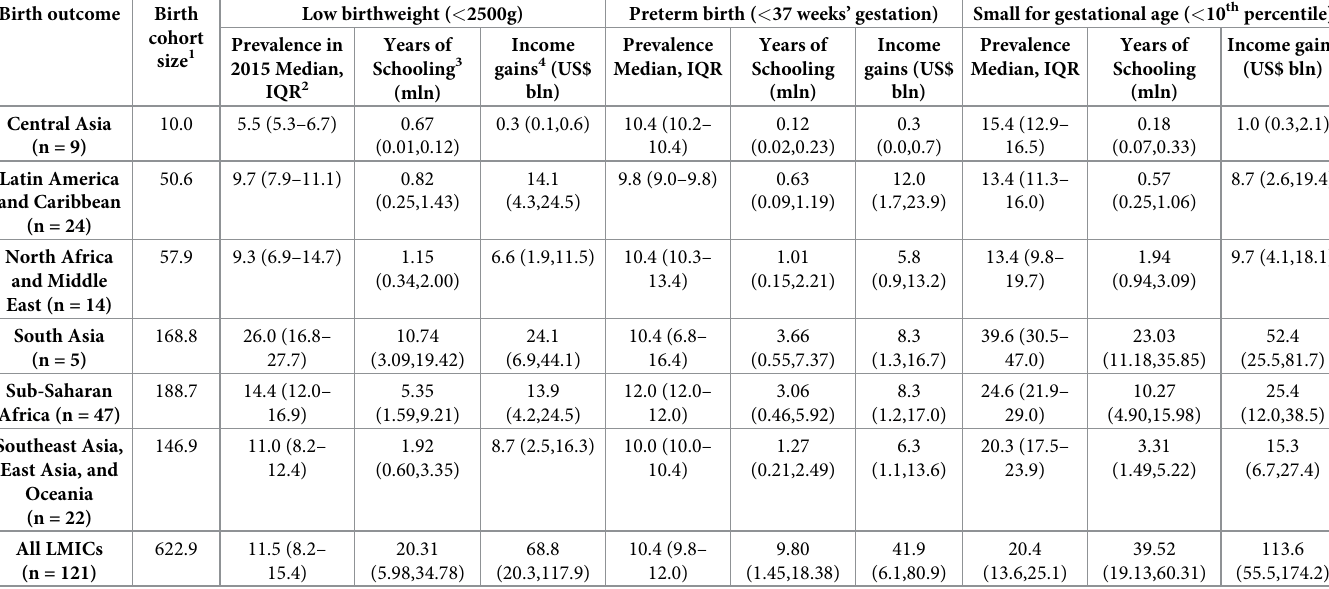
Table 2. Gains in years of schooling and net present value of lifetime income